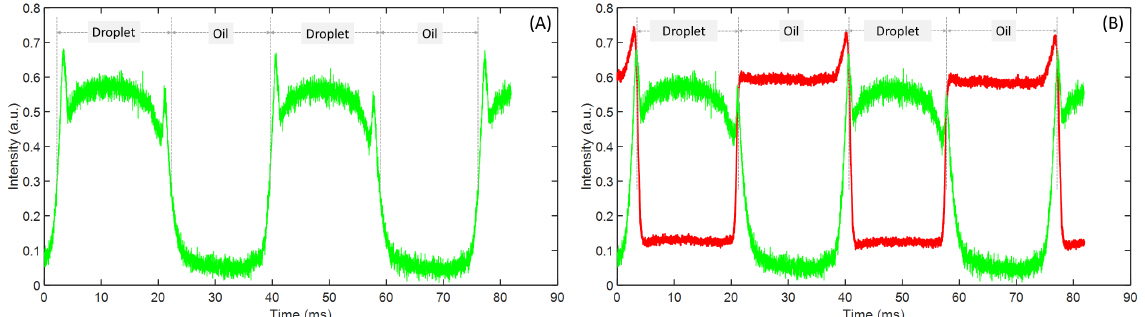
Figure 4. Emission of intense anti-Stokes signals from flowing droplets. ( A ) Stokes fluorescence intensity of large RhB in water droplets vs. time in HFE-7500 fluorocarbon oil stabilized by TBA- Krytox surfactant. ( B ) Both Stokes and anti-Stokes fluorescence intensities of RhB in water droplets (green signal) and fluorocarbon oil (red signal) in the presence of TBA-Krytox surfactant. One may remark that during the passage of the fluorocarbon oil plugs across the laser beam, an intense anti-Stokes fluorescence emission is